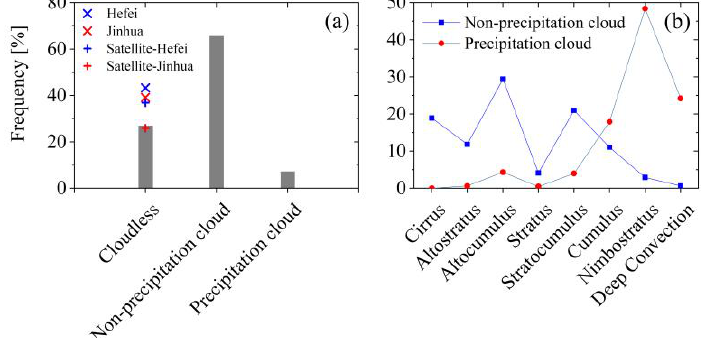
Figure 5. ( a ) Occurrence frequencies of cloudless, non-precipitation cloud, and precipitation cloud. The blue cross sign corresponds to the cloudless occurrence frequency for Hefei lidar site, and the red one for Jinhua lidar site. The cross symbol indicates the matched grid box. ( b ) Occurrence frequencies of eight cloud types for non-precipitation cloud or precipitation cloud.